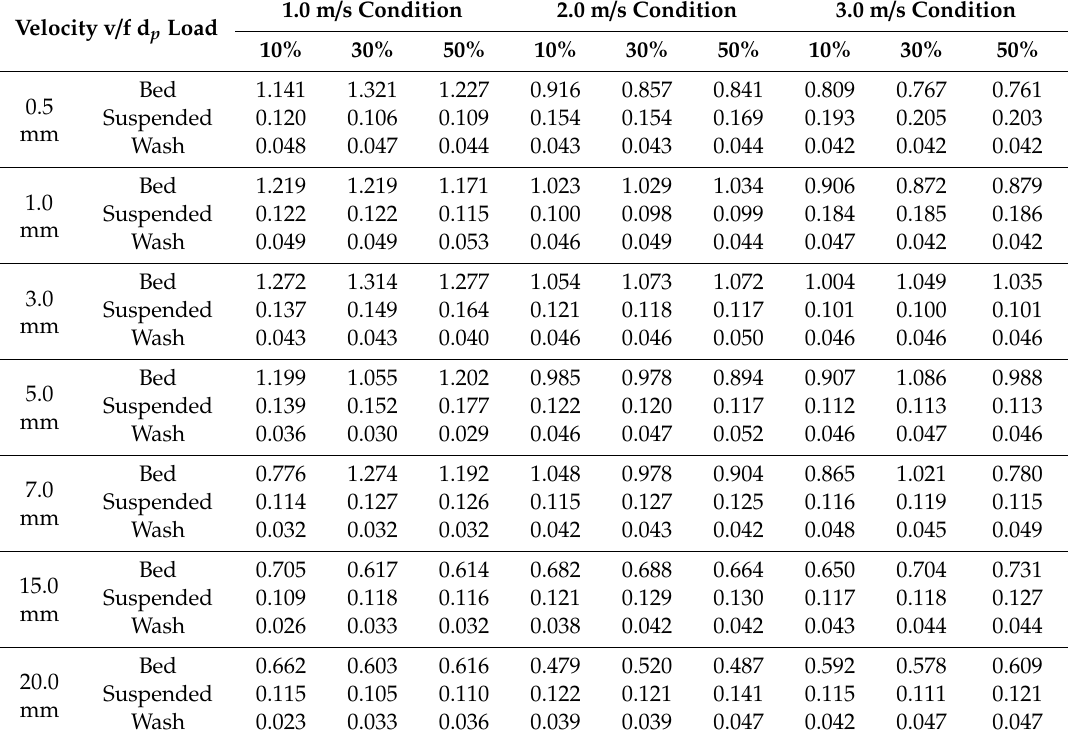
Table 5. Shear boundary layer in various conditions of sediment load and settling velocity. Settling velocity was calculated from numerical analysis results ( v s / u ∗